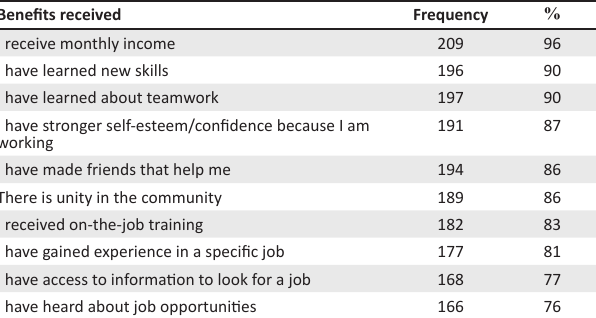
TABLE 4: Benefits received by respondents from the community work